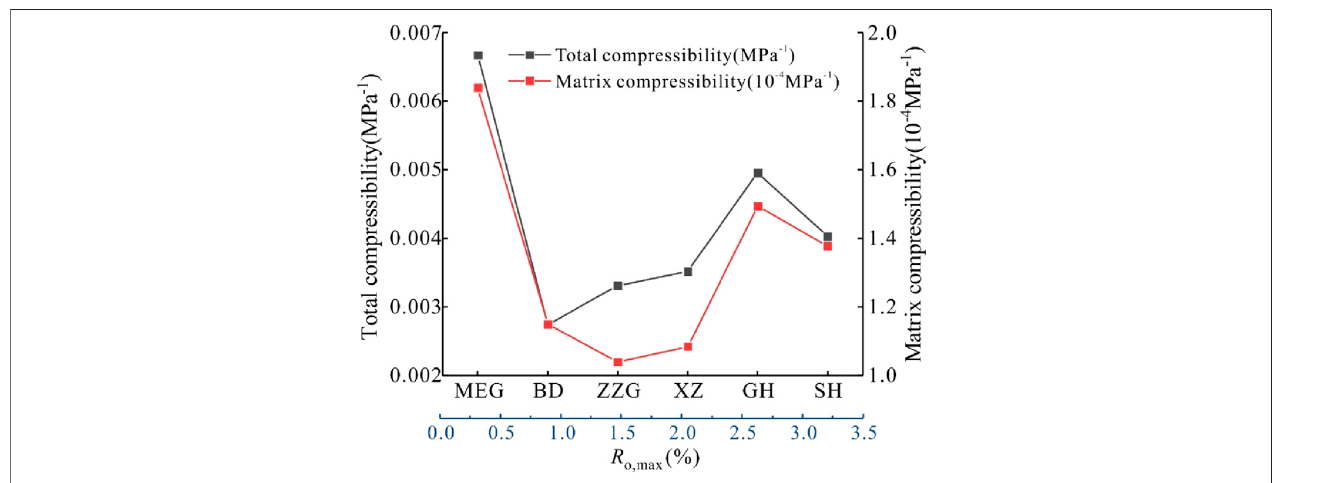
FIGURE 14 | Compressibility characterization based on HPMI and NMR